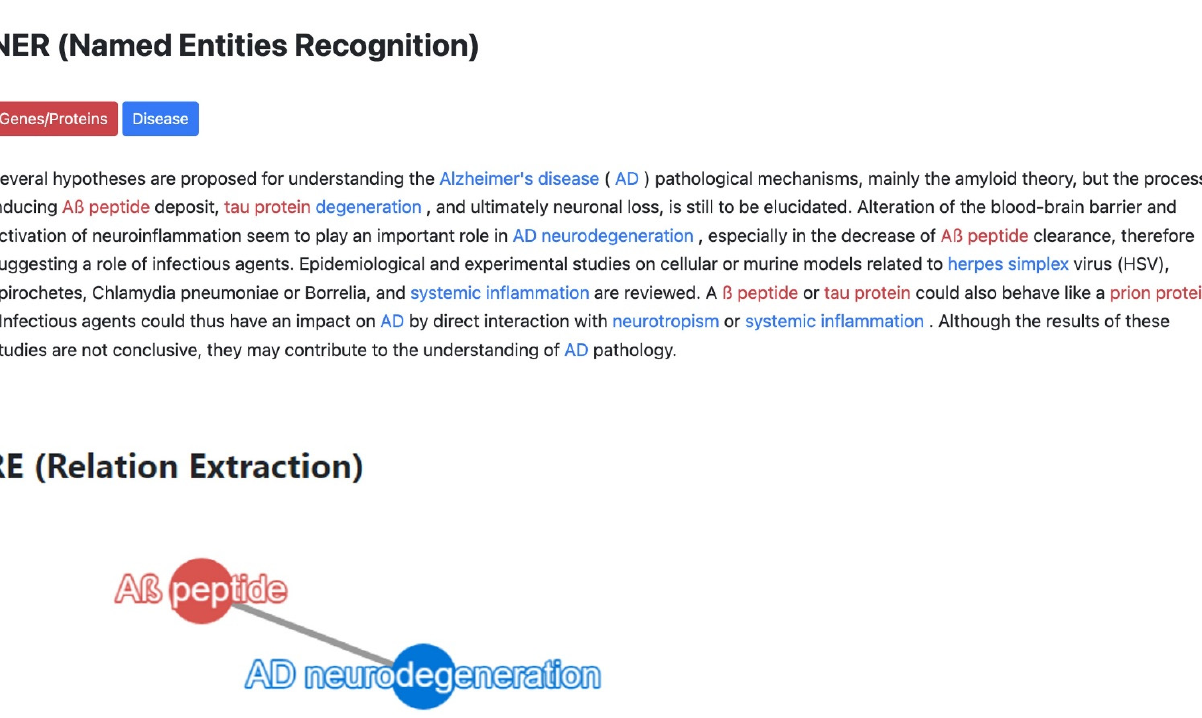
Figure 7. Original Web Interface of NER and RE with BERT.